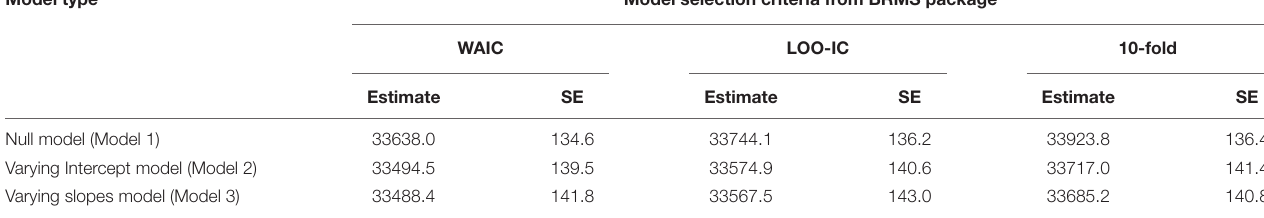
TABLE 4 | Model comparisons based on predictive